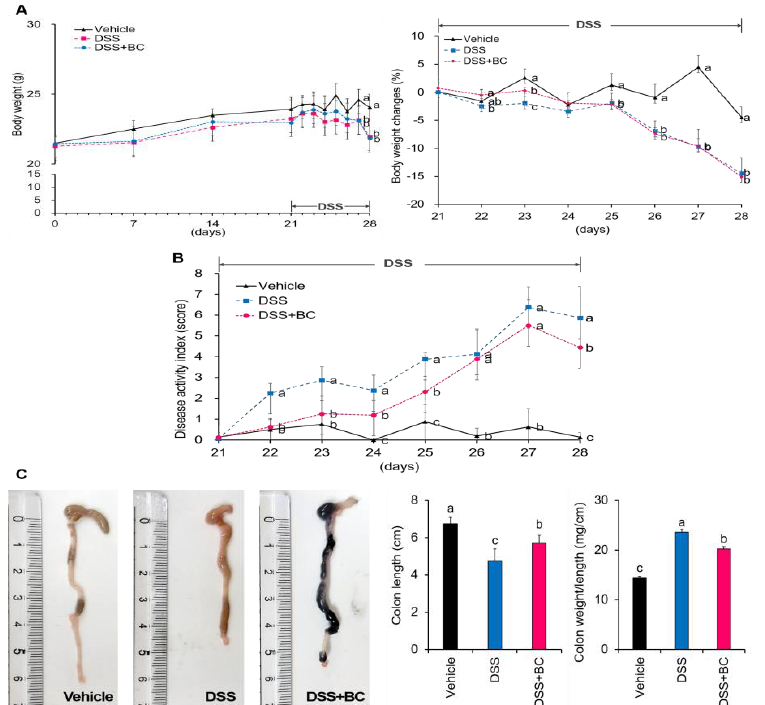
Figure 1. Effects of blackcurrant on the clinical symptoms of DSS-induced colitis. ( A ) Changes in body weight during the experiment period; ( B ) disease activity index (DAI); ( C ) representative images, and measurement of colon length and colon weight/length. The values are shown as mean ± SD ( n = 8 per group). Distinct lowercase letters indicate significant differences between groups through one-way ANOVA and Duncan’s post hoc tests ( p < 0.05). Vehicle, normal control group not treated with DSS; DSS, DSS control group; DSS + BC; DSS + blackcurrant